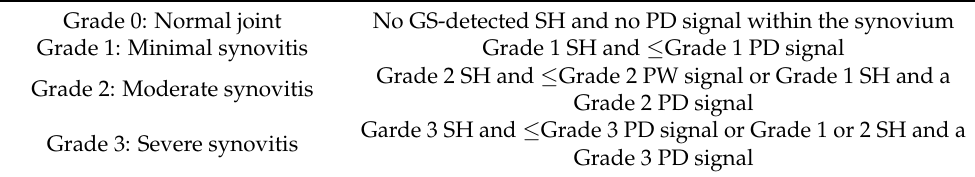
Table 2. EULAR–OMERACT combined scoring system for grading synovitis in rheumatoid arthritis. (GS: gray scale, SH: synovial hypertrophy, PD: power